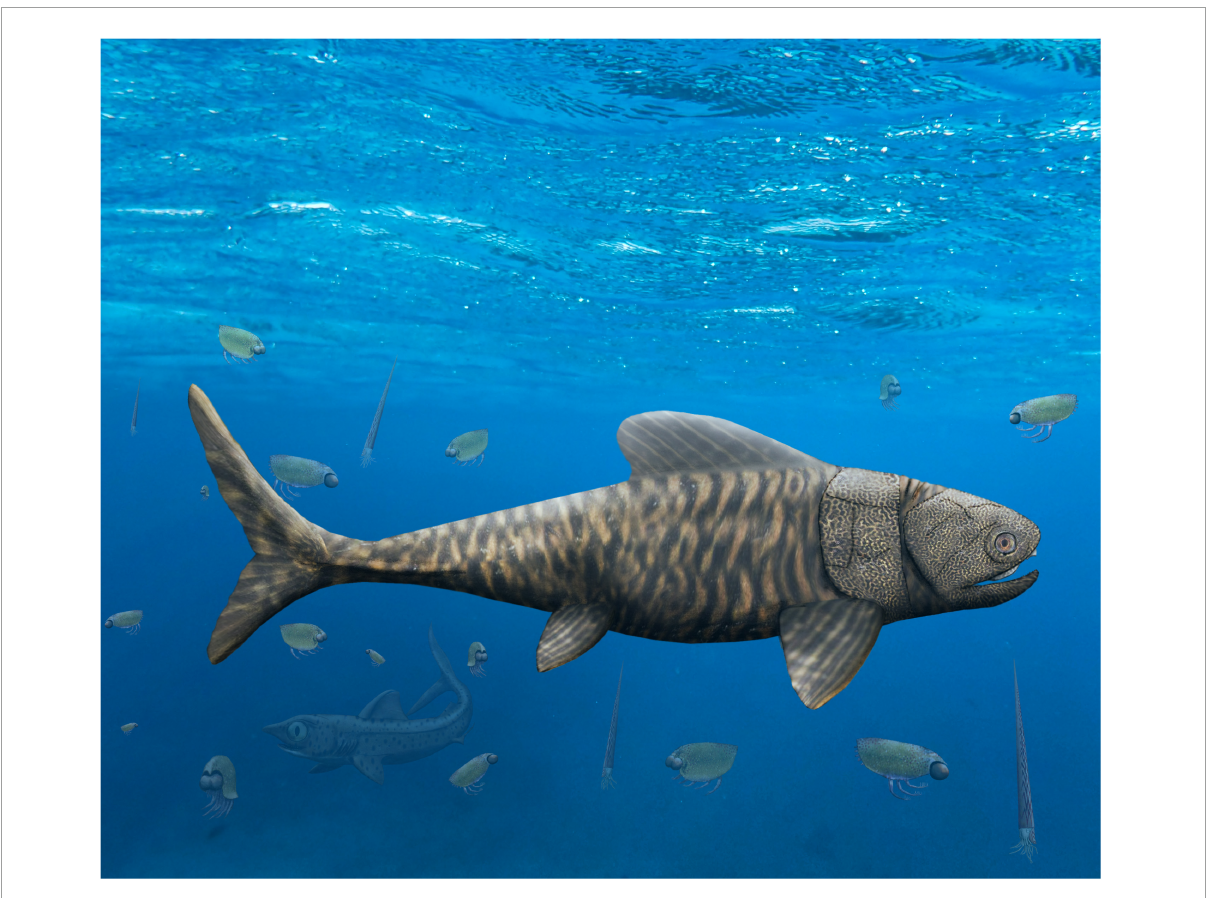
FIGURE10 Reconstruction of Amazichthys trinajsticae gen. et sp. nov.